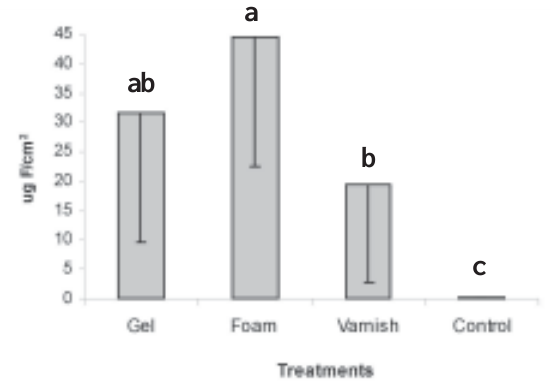
” (µg F/cm 2 ) formed on enamel after the FIGURE 1 - “CaF 2 treatments (mean, sd; n=10) Treatments with means followed by distinct letters are statistically different (p <